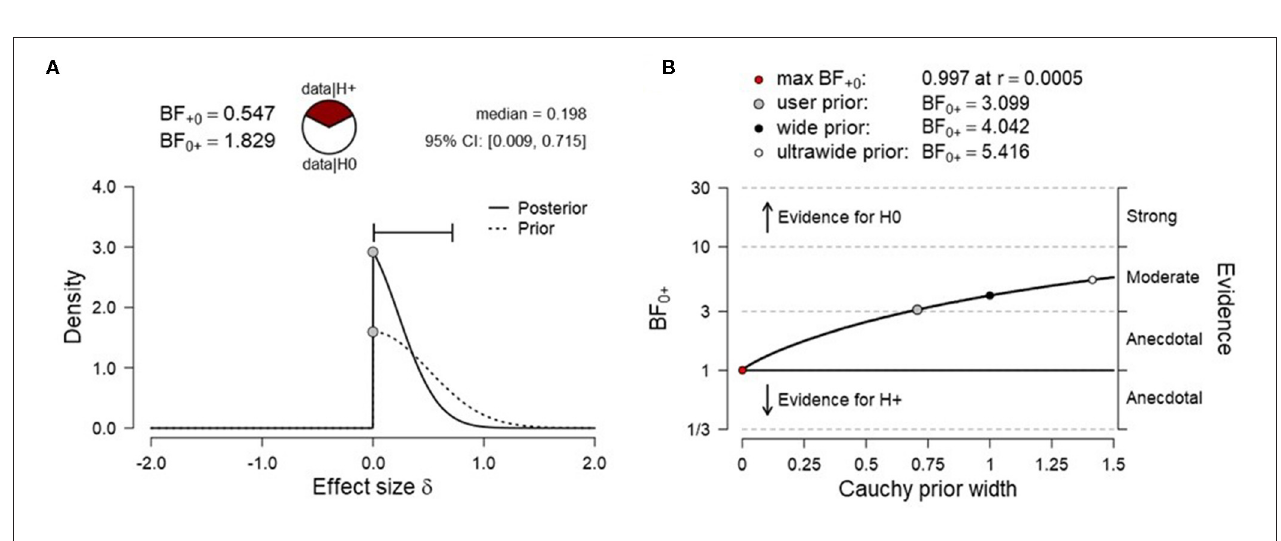
FIGURE 4 | (A) Prior and posterior distribution for Bayesian t test and associated Bayes factor and effect size estimates for H1 B [more supplementary motor area (SMA) activation for the high vs. low target level condition]. (B) Corresponding prior sensitivity analysis for a set of default Cauchy prior scaling settings.